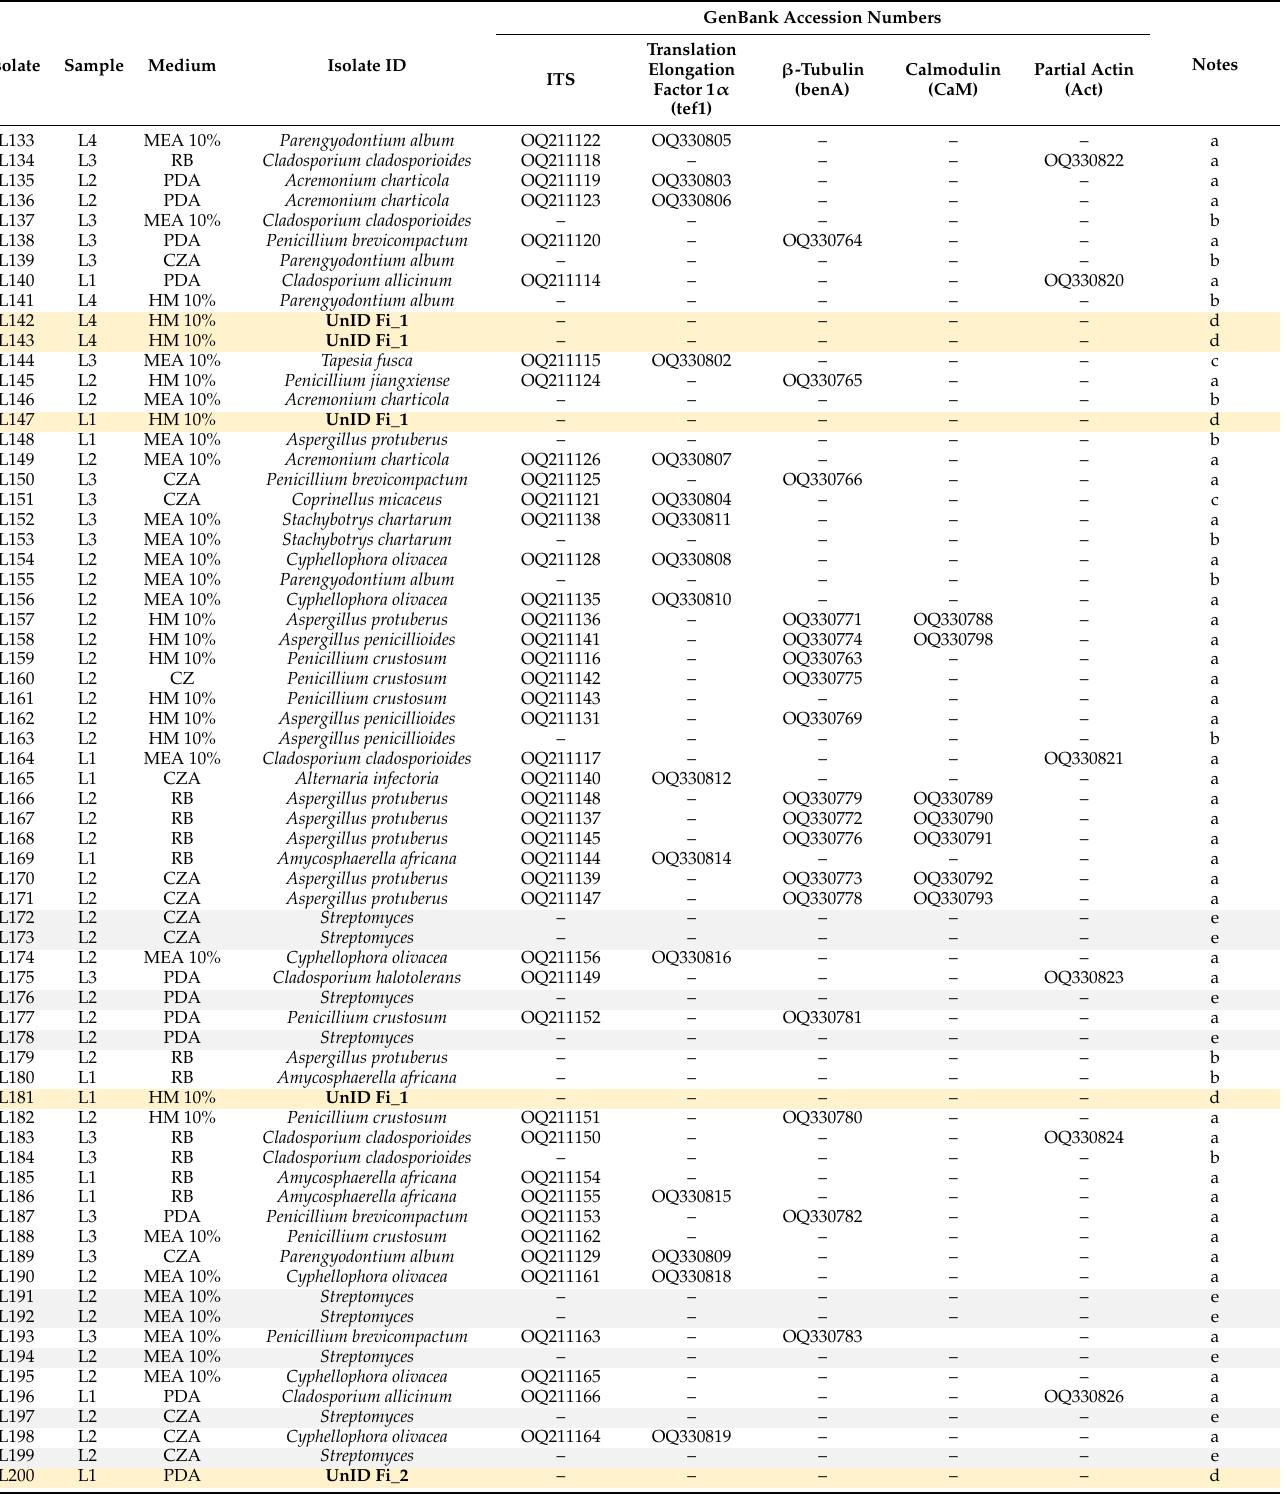
Table A1. The provenance of all isolates and GenBank accession numbers of fungal isolates retrieved in this